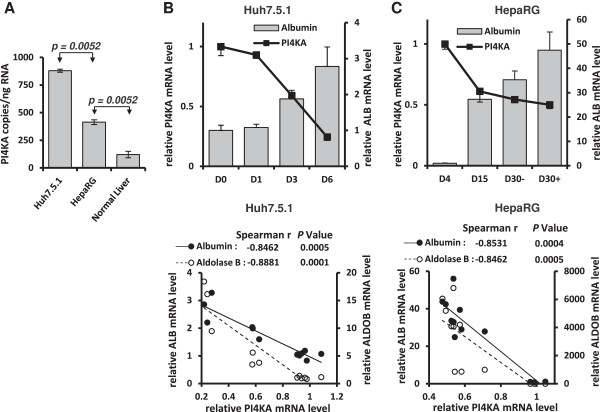
PI4KA mRNA in in vitro models according to their hepatic differentiation state. Determination by RT-real time PCR of copy numbers of PI4KA transcripts in sub-confluent cultures of Huh-7.5.1 (n = 3) or HepaRG (n = 3) and in normal human liver tissues (n = 31) (A). P values from Mann–Whitney U-tests are indicated. Huh-7.5.1 (B) and HepaRG (C) cell lines were subjected to specific differentiation protocols over several days (see details in Methods section). PI4KA and hepato-specific (albumin and aldolase b) transcripts were assayed by RT-real time PCR at the time points indicated, in three independent experiments. Results are expressed in amounts relative to those at the first time point. The mRNA levels of the succinate dehydrogenase complex, subunit A (SDHA) were used for normalization. The top panels show the comparative expression of PI4KA and albumin. The bottom panels present the correlations between PI4KA and albumin or aldolase B expression levels. Spearman’s rank order coefficients and P values are indicated above the graphs.